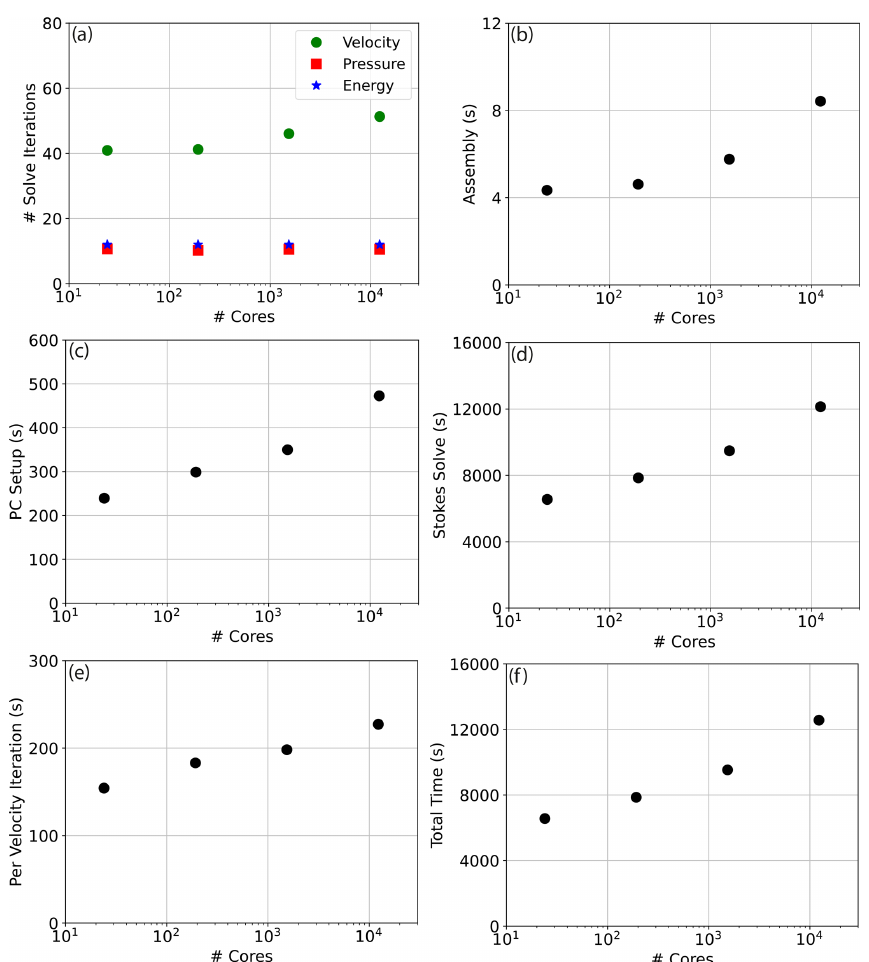
Figure 10. Weak scaling analyses for a 20 time-step, temperature-dependent viscosity, spherical shell simulation with free-slip boundary conditions: (a) mean number of iterations per time step for energy (blue stars), pressure (red squares) and velocity (green circles) solves respectively; (b) time spent in assembly of finite-element systems; (c) time spent setting up the algebraic multigrid preconditioner; (d) time spent solving the Schur complement (Stokes) system; (e) cost per velocity solve iterations; (f) total simulation time, which closely mimics the Schur complement solution